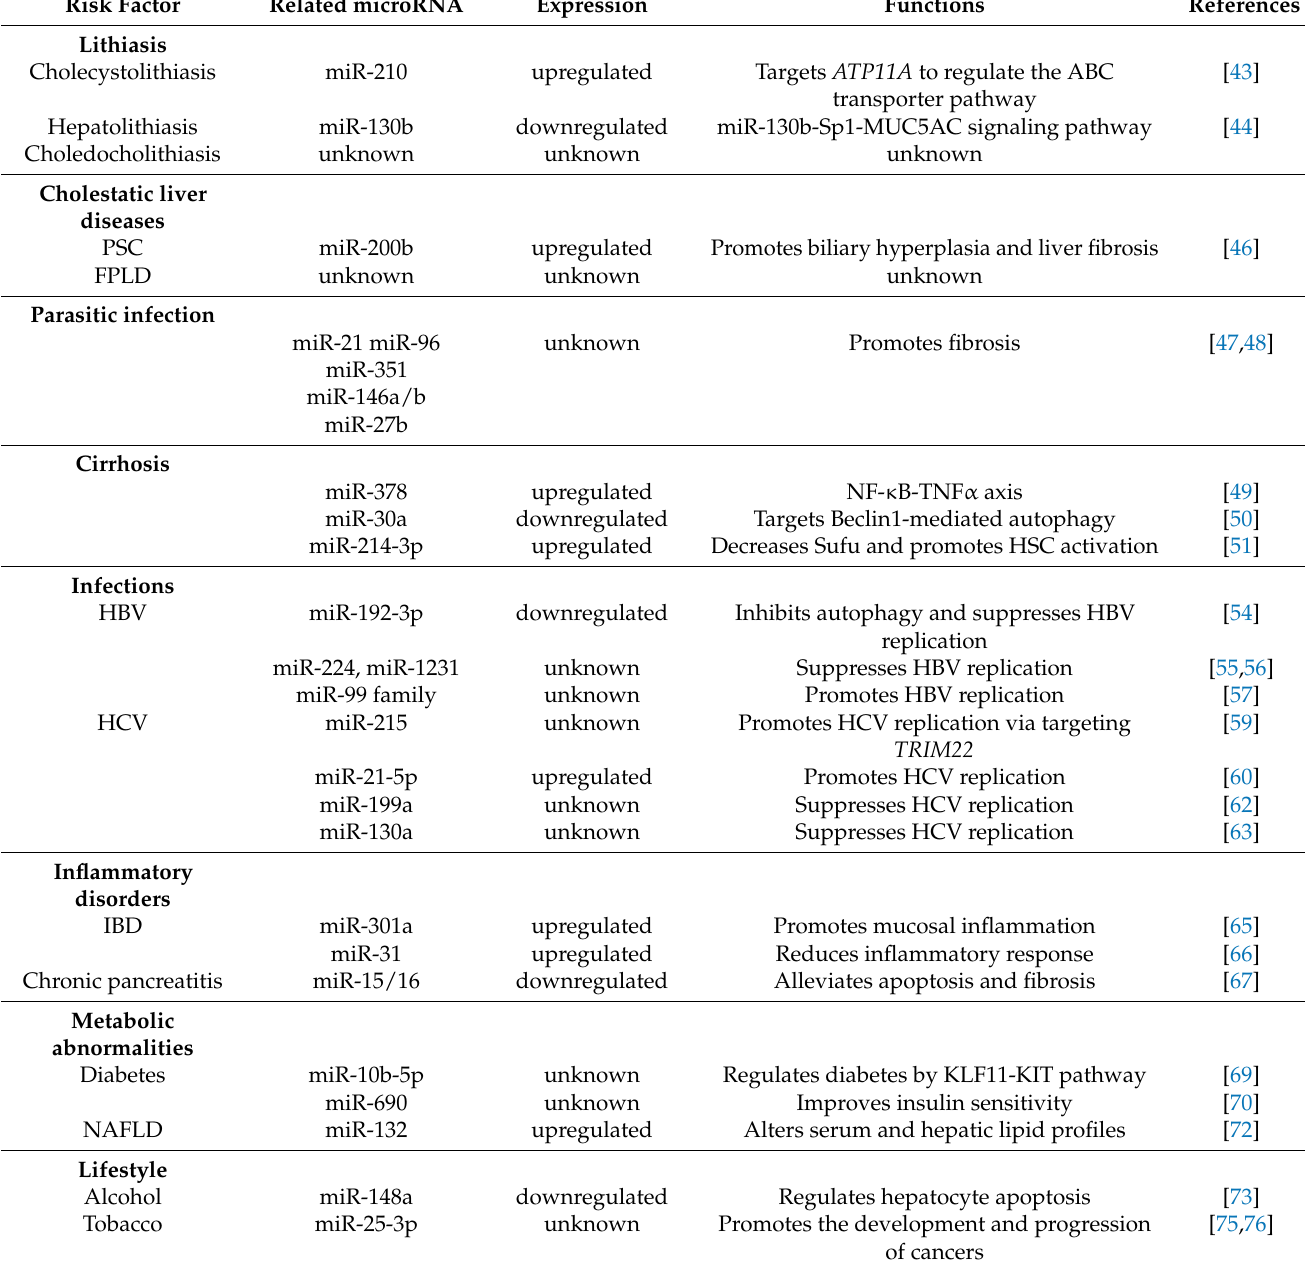
Table 1. microRNAs (miRNAs) associated with cholangiocarcinoma risk